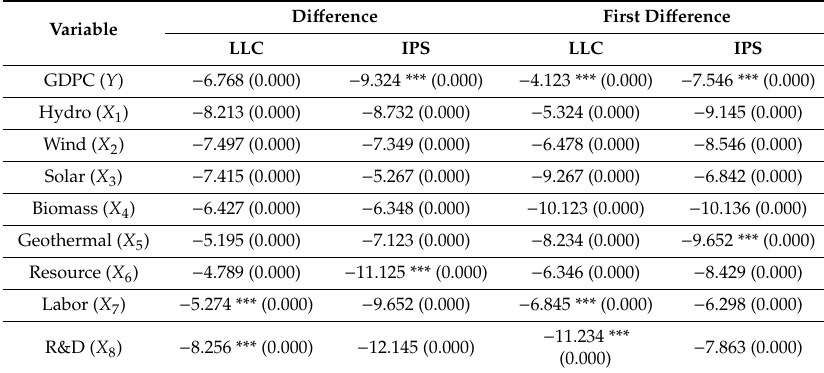
Table 5. Panel unit root test results for the EU countries, in